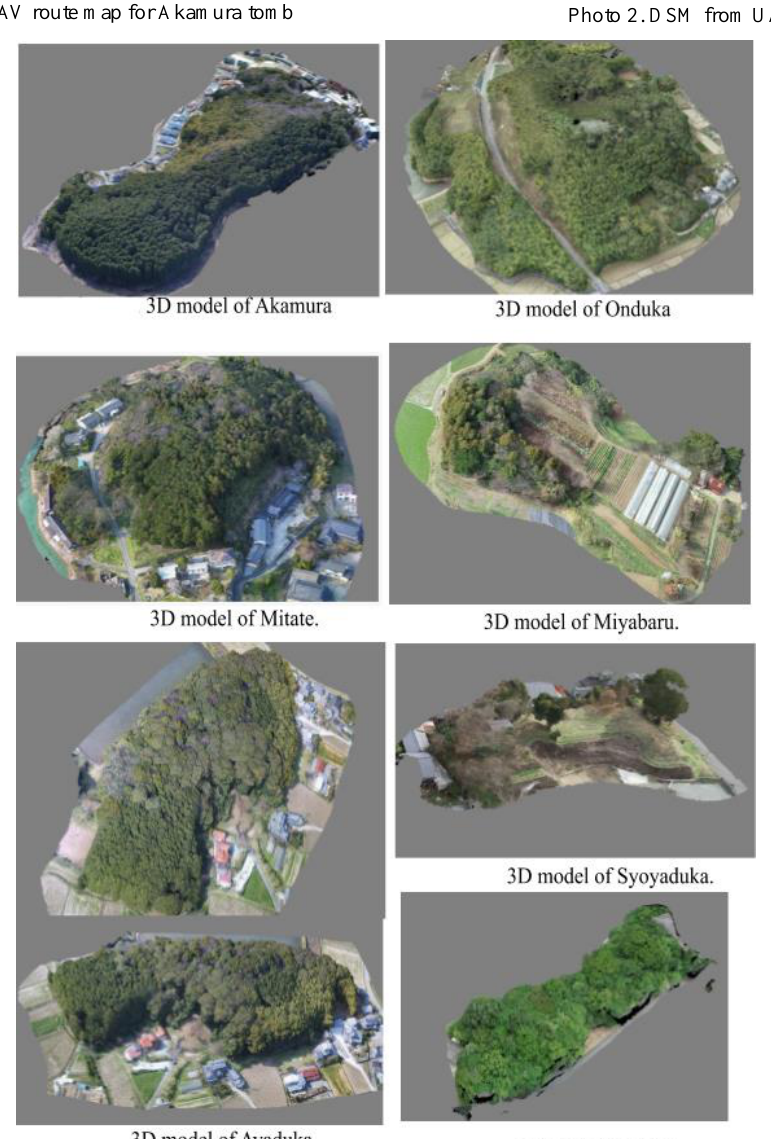
Photo 2. DSM from